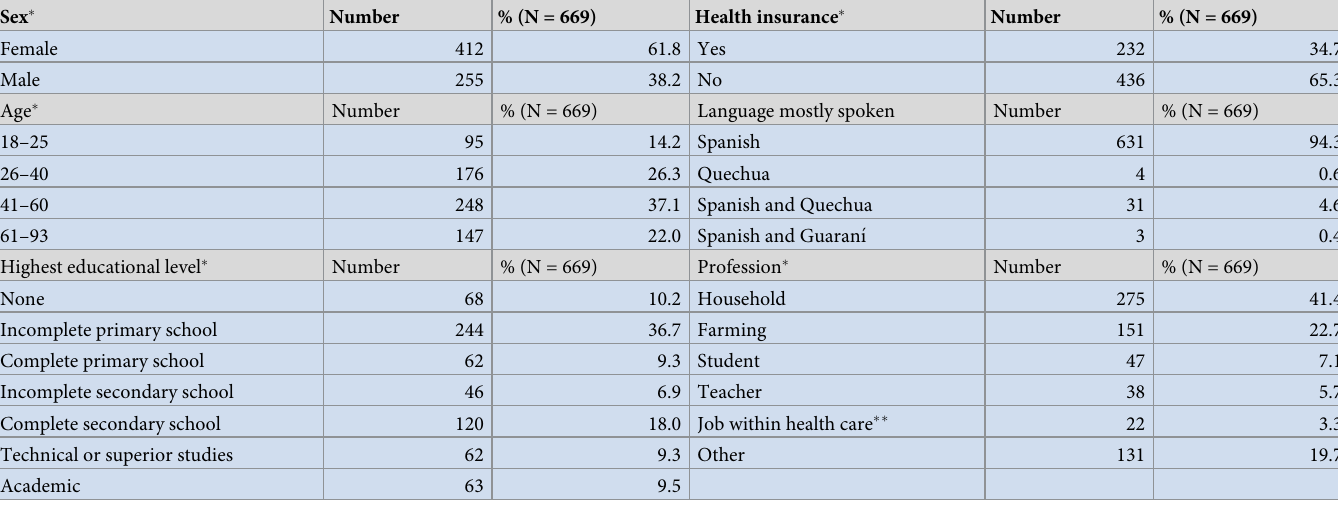
Fig 3. Geographic distribution of included communities. A total of 26 communities were included in this study. Sizes of dots represent the respective number of households in each community. https://doi.org/10.1371/journal.pntd.0008752.g003 Table 1. Included participants. Selected socio-economic data on included household